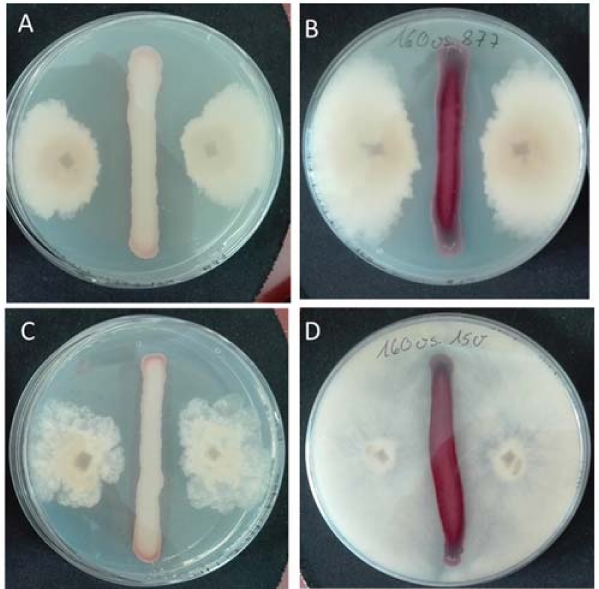
Figure 2. Antagonistic interactions on the PDA plates. M. pulcherrima 160 and B. cinerea DSM 877 in the presence of ( A ) 5 mg/L FeCl 3 and ( B ) 20 mg/L FeCl 3 ; M. pulcherrima 160 and B. cinerea V15 in the